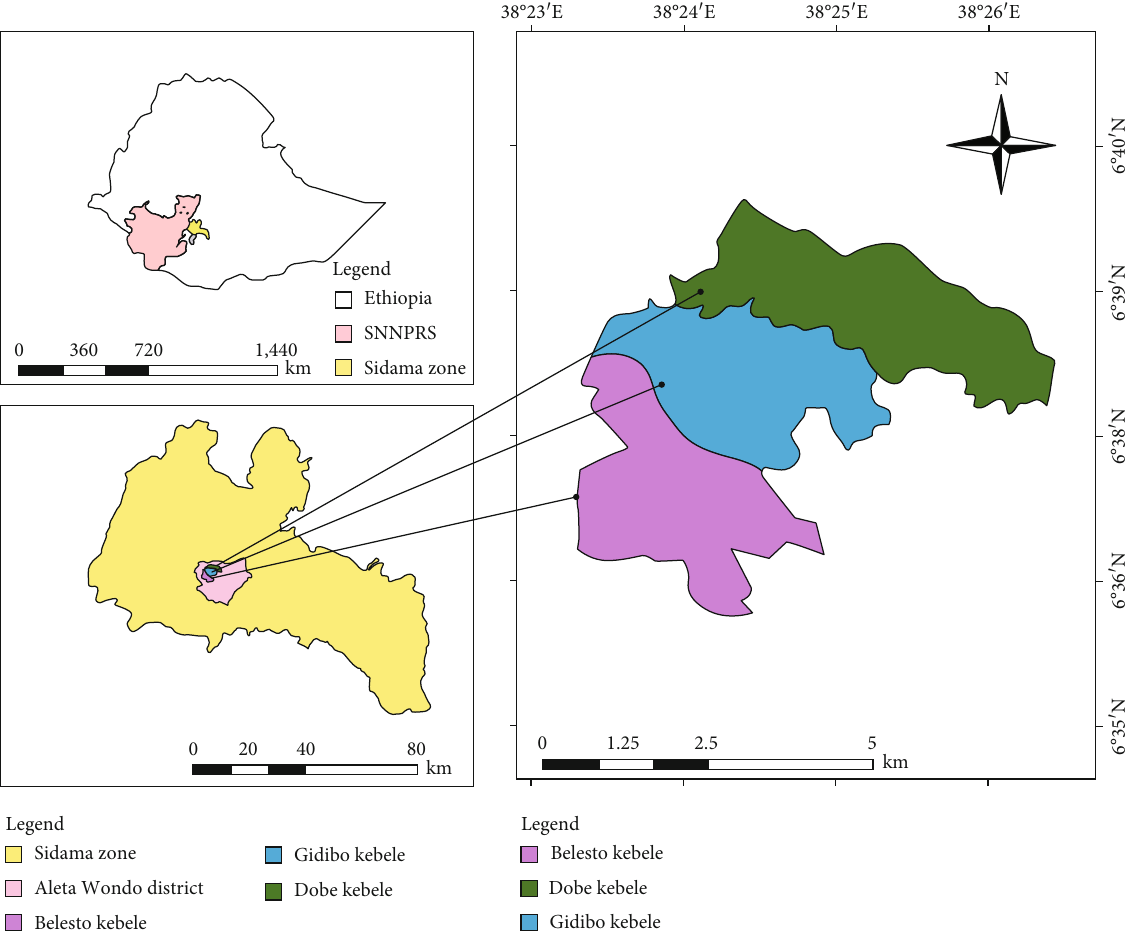
Figure 1: Map of the study